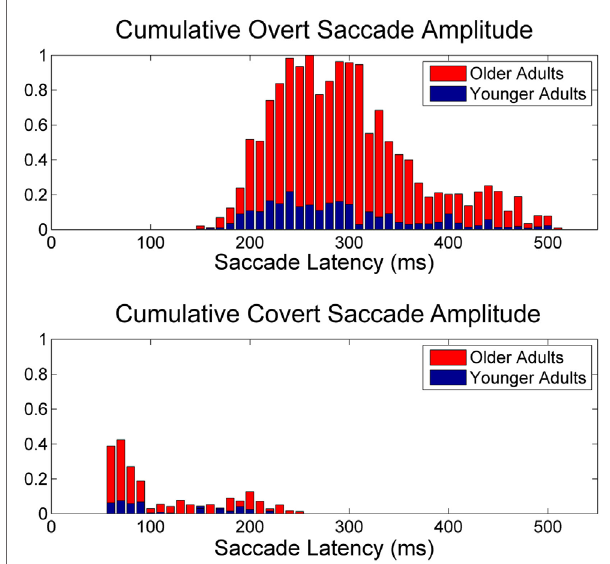
FigUre 3 | normalized saccade amplitude . Normalized cumulative saccade amplitude for overt (upper panel) and VOR corrected covert (lower panel) saccades as a function of latency following onset of head impulse. Note the normalized cumulative amplitude is larger for older adults ( ≥ 60 years) relative to younger adults ( < 60 years) and that overt saccades have larger amplitude compared to covert saccades after correcting for VOR eye velocity and